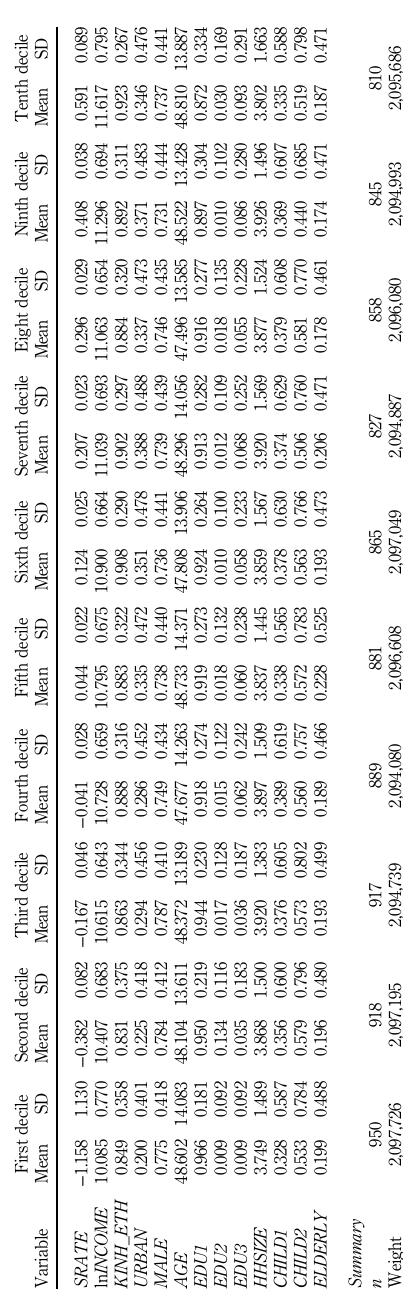
Table AI. Mean and standard deviation in the ten deciles of the saving rate